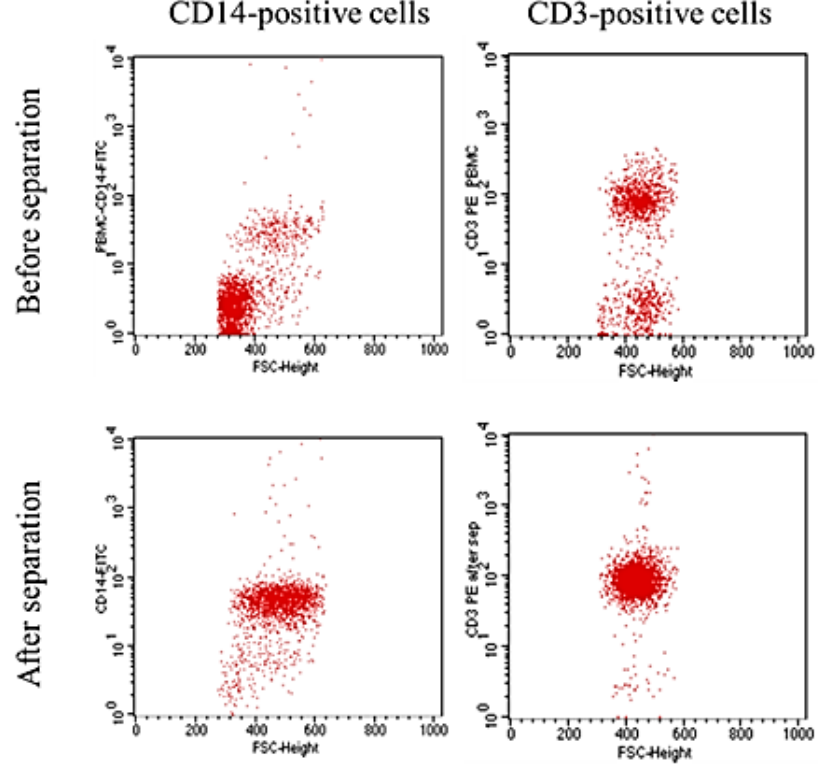
Figure 2. Flow cytometric analysis of untouched CD14- and CD3-positive cells separated by buffer optimized high gradient magnetic separation (HGMS) (negative selection). Plots show CD14- and CD3-positive cells before and after magnetic separation. CD14-positive cells were enriched from 17% to 95% and CD3-positive cells from 62% to 96%.